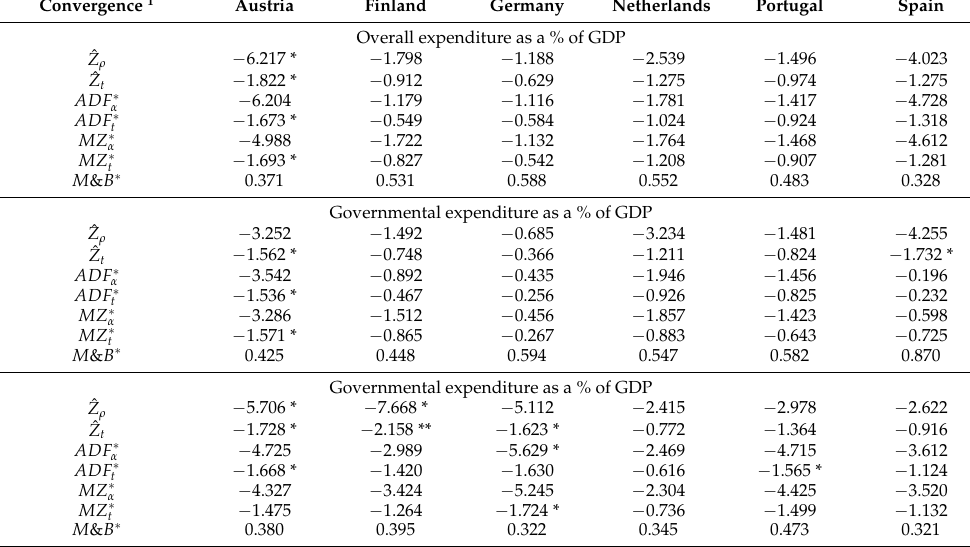
Table 3. Results for bounded unit root tests – health expenditure as a % of GDP.